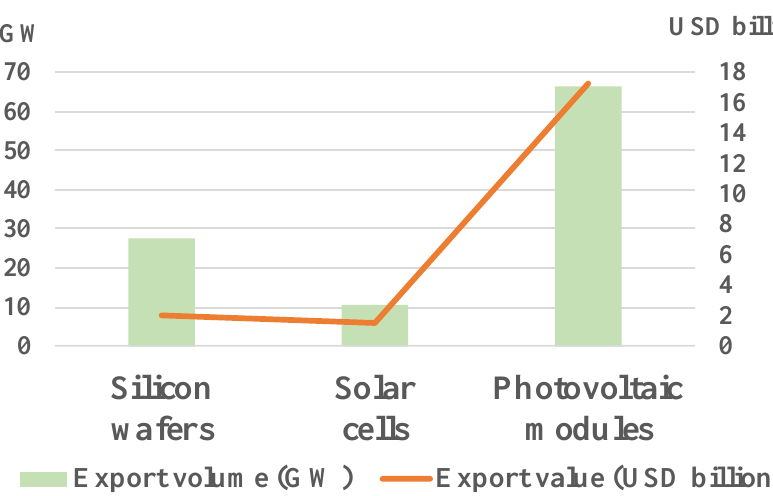
Figure 12. Export volume (GW) and export value (USD billion) of China’s main photovoltaic products in 2019 [69].